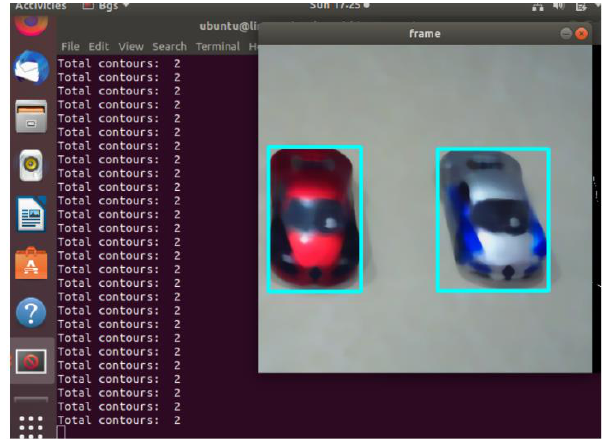
Figure 9b. Lane 2 vehicle